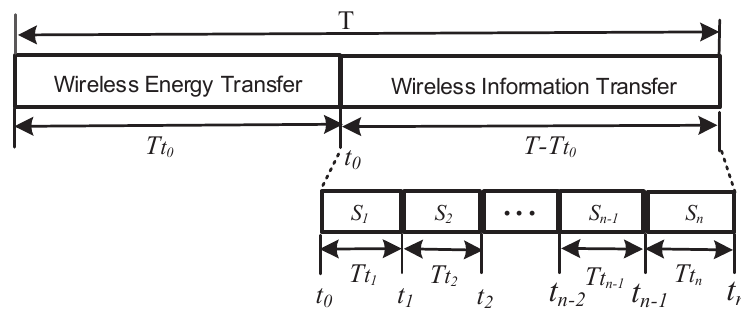
Figure 2. The time division multiple access (TDMA)-based transmission